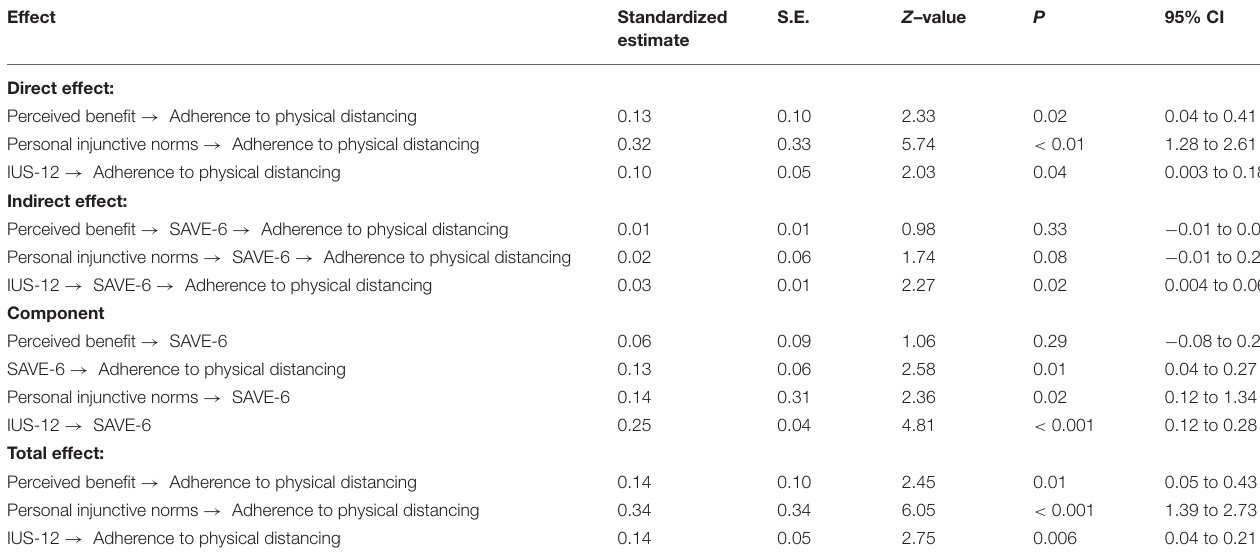
TABLE 5 | The results of mediation